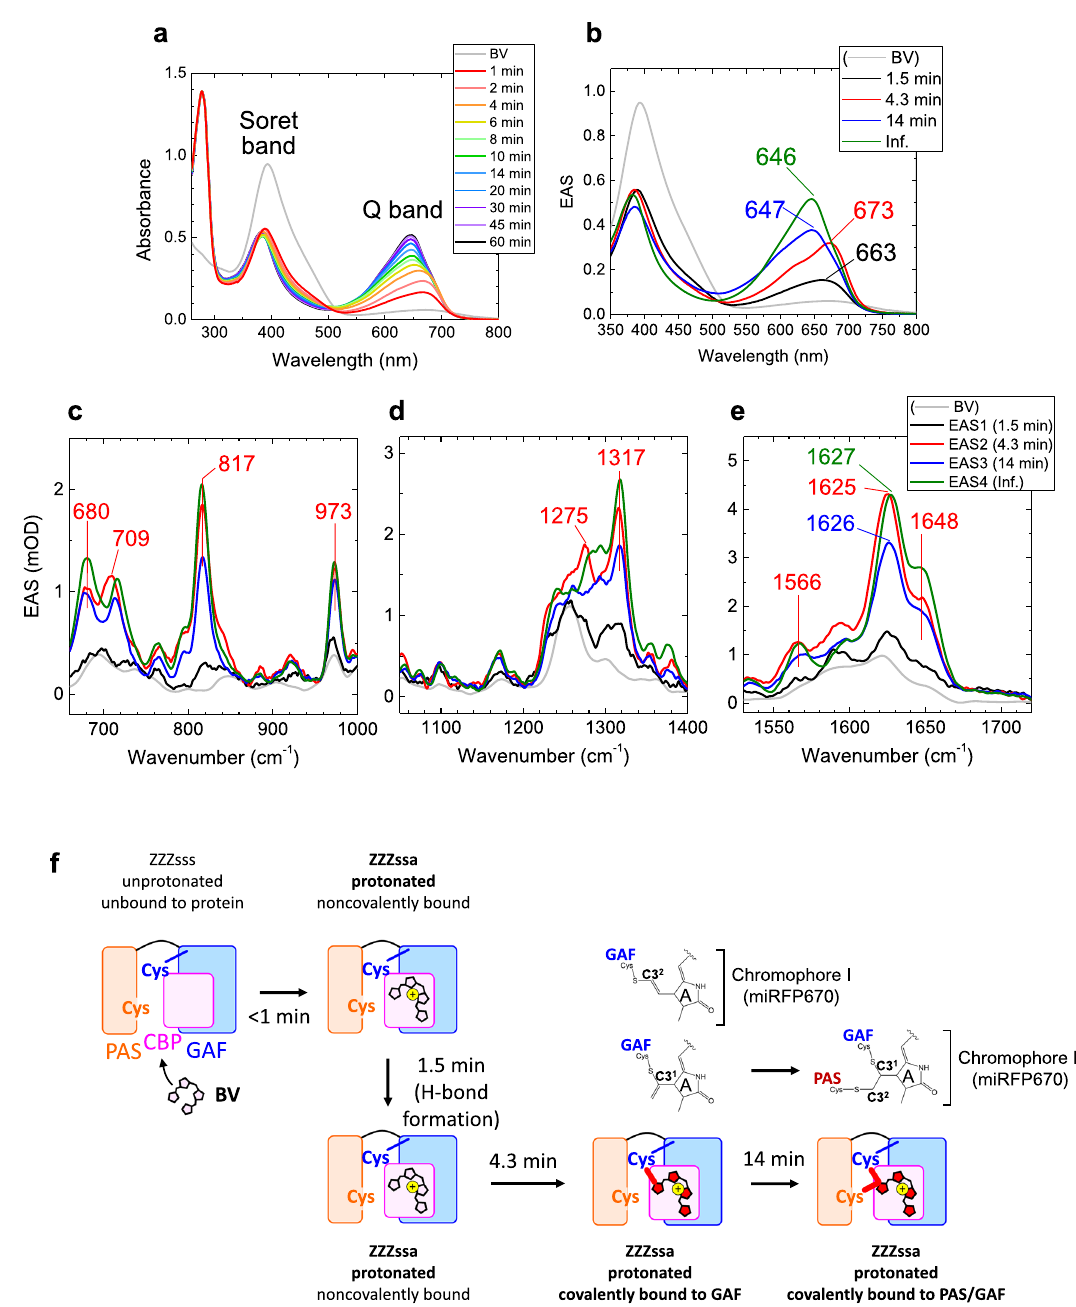
Fig. 4 Time-resolved absorption and Raman spectra of miRFP670 at pH 8.0 and incorporation model of miRFP670. a Selected time-resolved absorption spectra taken at the times indicated. b Evolution-associated spectra (EAS) of globally fi tted time-resolved absorption spectra. c – e EAS of globally fi tted time-resolved stimulated Raman spectra with an 800 nm Raman pump. The indicated time constants denote the lifetime by which each EAS evolves into the next one. f Biliverdin (BV) incorporation model of